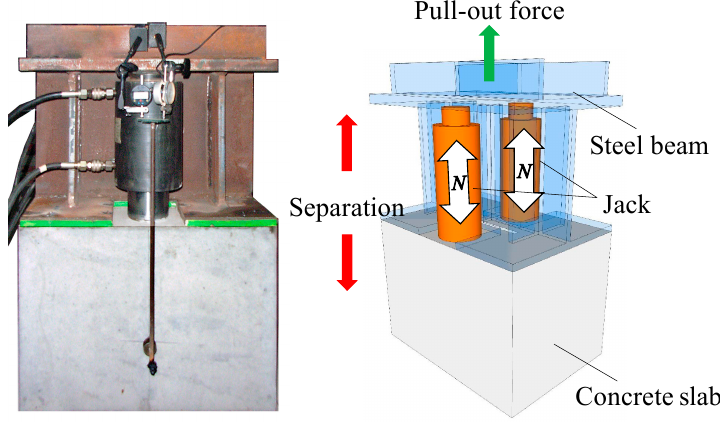
Figure 4. Test setup and instrumentation.